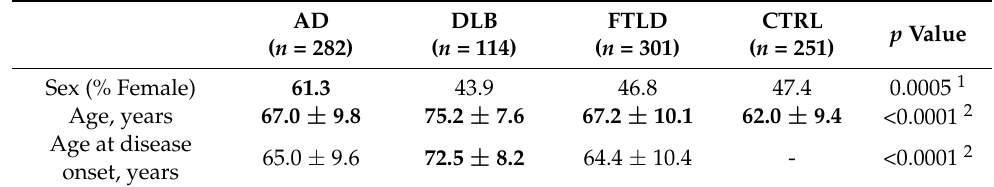
Table 1. Demographic variables of patients and controls.